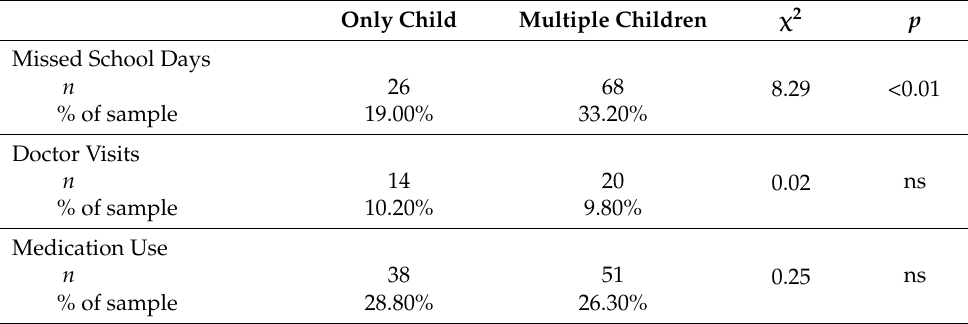
Table 6. Crosstabs for school days missed, doctor visits, and medication